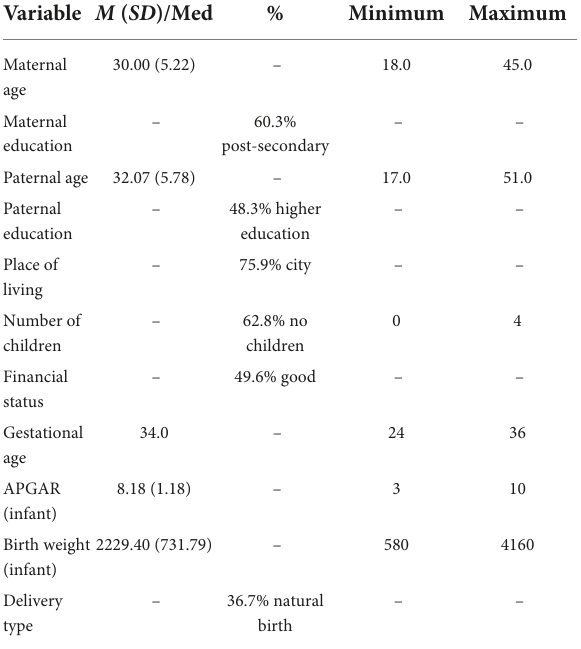
TABLE 1 Socio-demographic variables of the study